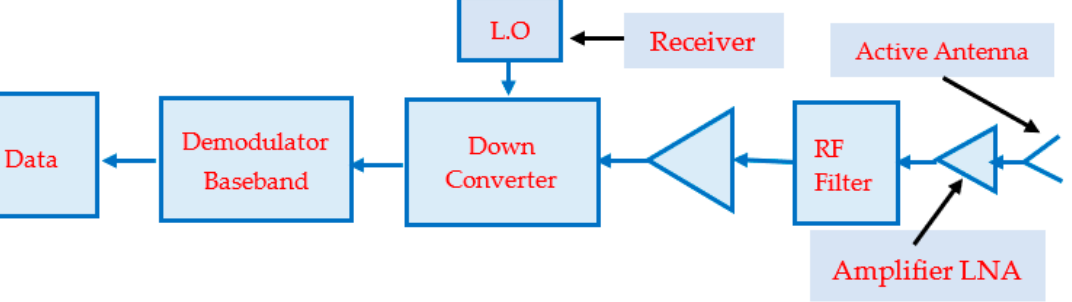
Figure 5. Receiver block diagram with wearable active antenna.